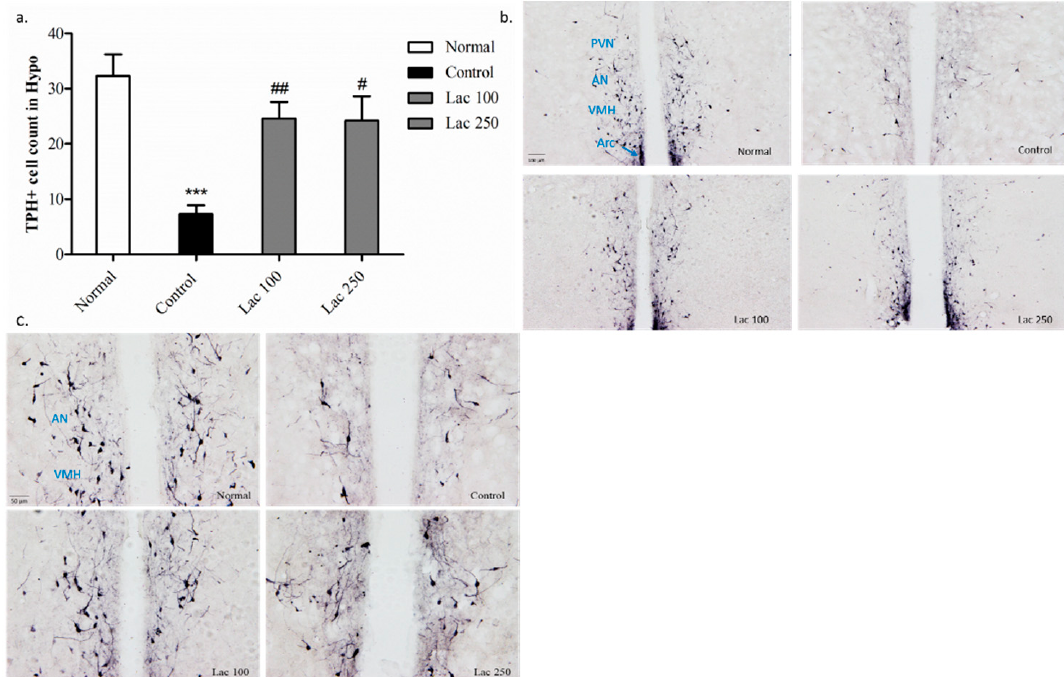
Figure 7. Oral lactate administration enhanced tryptophan hydroxylase (TPH) expression in the hypothalamic nuclei. ( a ) The decreased number of TPH+ cells in the control group was notably upregulated in the lactate 100 and 250 groups. ( b , c ) Representative images of TPH+ cell expression in the hypothalamic nuclei (the scale bars represent 100 and 50 µ m, respectively). PVN = paraventricular hypothalamic nucleus, AN = anterior hypothalamic nucleus, VMH = ventromedial hypothalamic nucleus, Arc = arcuate nucleus. Values are presented as mean ± SEM. *** show differences between the normal and control groups, while # and ## show significant differences between the control group and treatment groups. # p < 0.05 and ## p < 0.01. The p -value of the test was <0.001 by one-way ANOVA, followed by a post hoc LSD test ( n = 6).